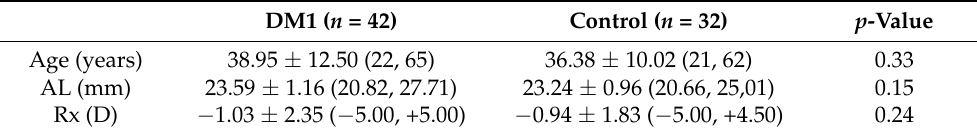
Table 1. Group means, standard deviation and range of age, axial length (AL), and refraction (Rx). Independent t -test was applied for comparison between DM1 ( n = 42) and control ( n = 32) groups. DM1 ( n = 42)